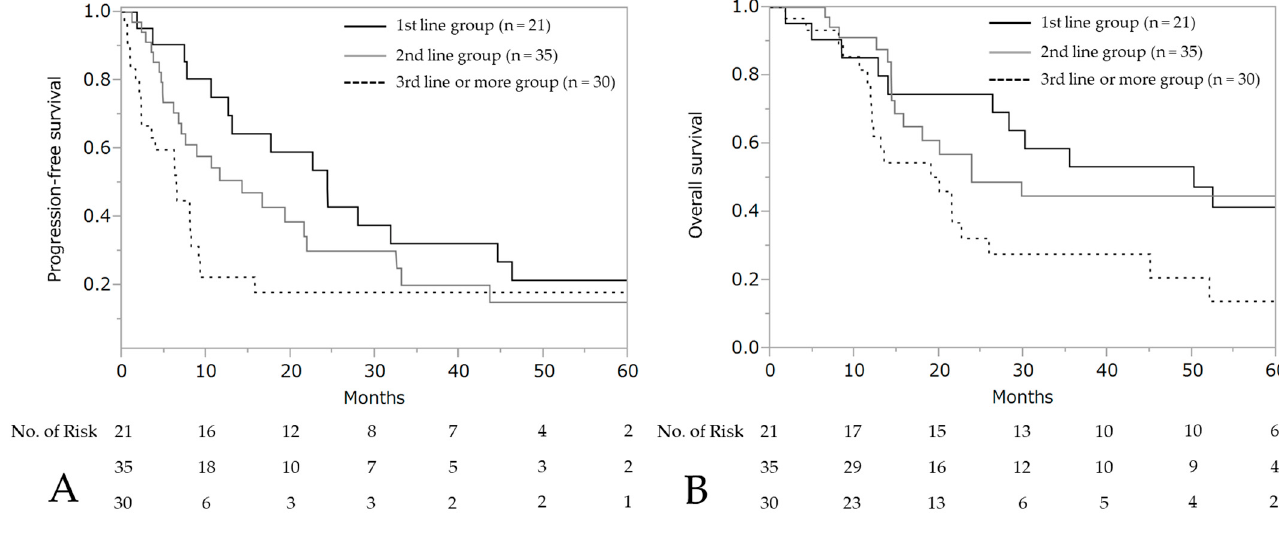
Figure 4. Progression-free survival and overall survival according to each line. Progression-free survival ( A ) and overall survival ( B ) after wTP survival ( B ) after wTP initiation.